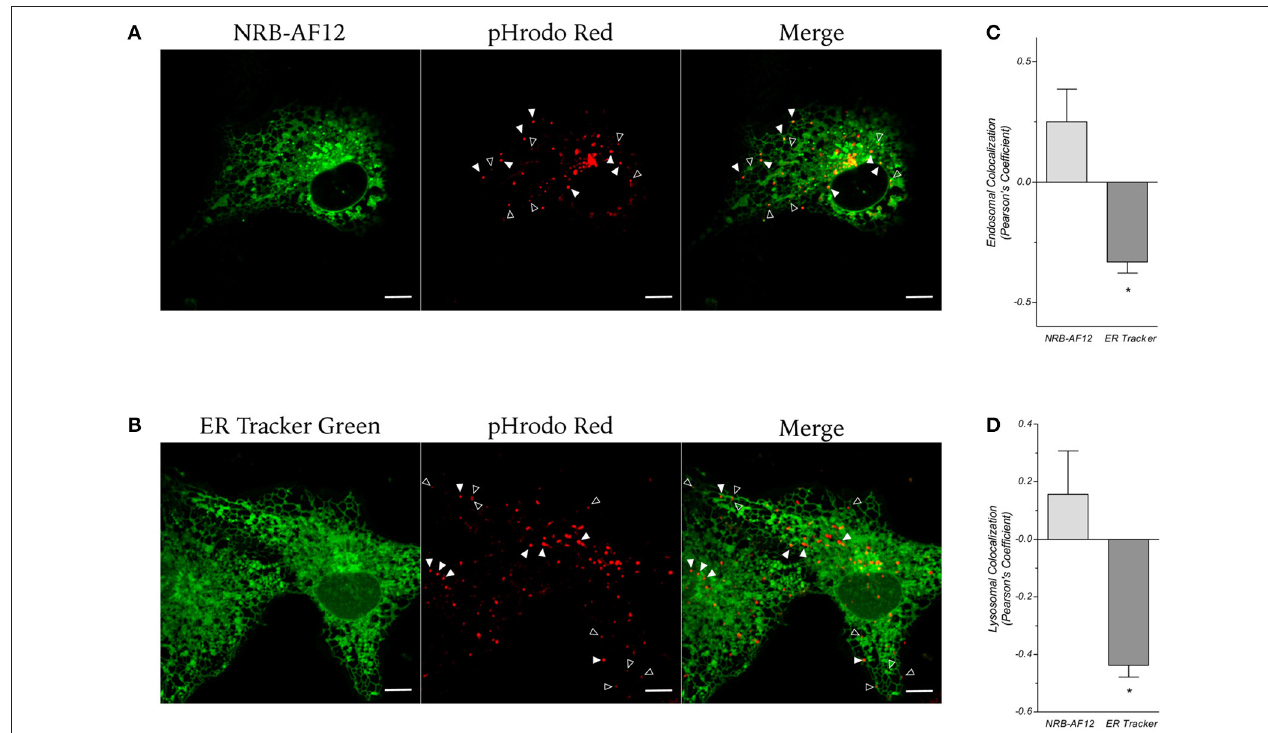
FIGURE 7 | Confocal live cell microphotographs of LX2 cells stained with the fluorescent dye for endosomal (empty arrowhead) and lysosomal (full arrowhead) compartments pHrodo red and (A) NRB-AF12 or (B) ER-Tr green. Magnification 60x; scale bar 10 µ m. (C,D) Co-localization of NRB-AF12 and ER-Tr Green with endosome and lysosome vesicles is shown as Pearson’s coefficient (* p < 0.05; n ≥ 10).